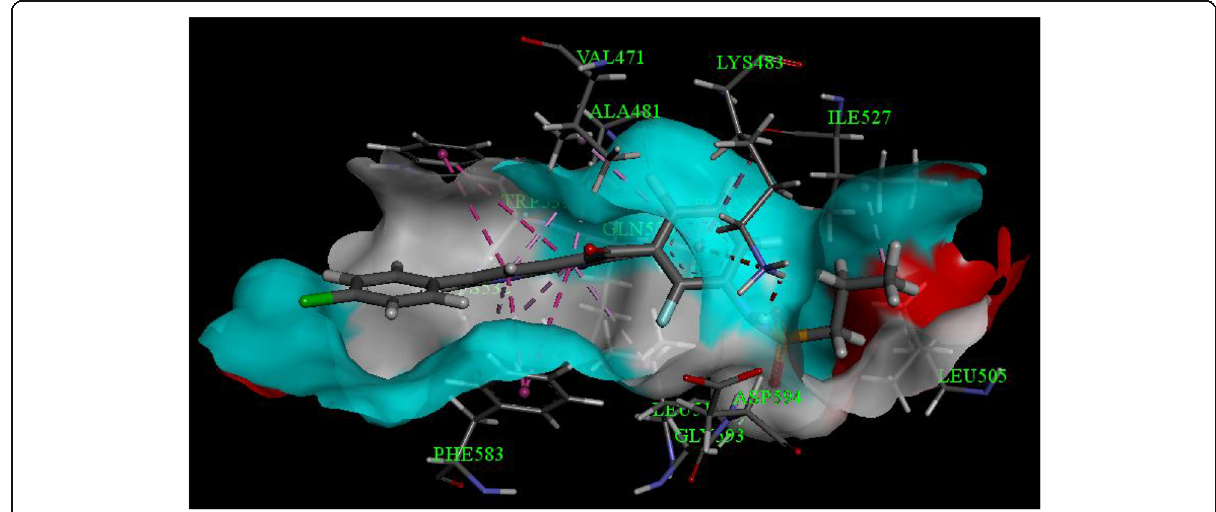
Fig. 5 3D diagram for the interaction of vemurafenib with